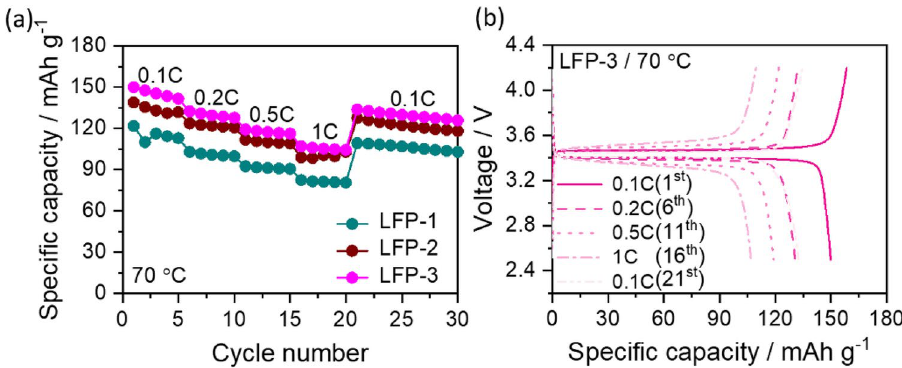
Figure 3. ( a ) Comparative rate capability curves of Li/SPNE/LFP cells having LFP-1 to LFP-3 cathodes and ( b ) the corresponding charge/discharge curves for LFP-3 cathode measured at 70 °C at different current rates.